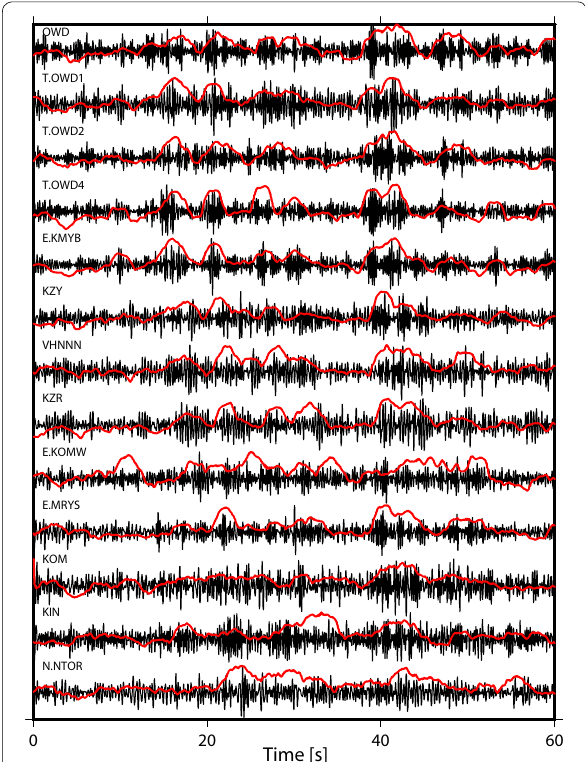
Fig. 6 Example of a 1-min waveform record from each station, taken during the volcanic tremor. Black traces indicate the vertical components of velocity waveforms for the period 2:32:20–2:33:20 on July 1, 2015, to which a band-pass filter between 2 and 6 Hz has been applied. Red traces indicate three-component RMS envelopes for the band-passed